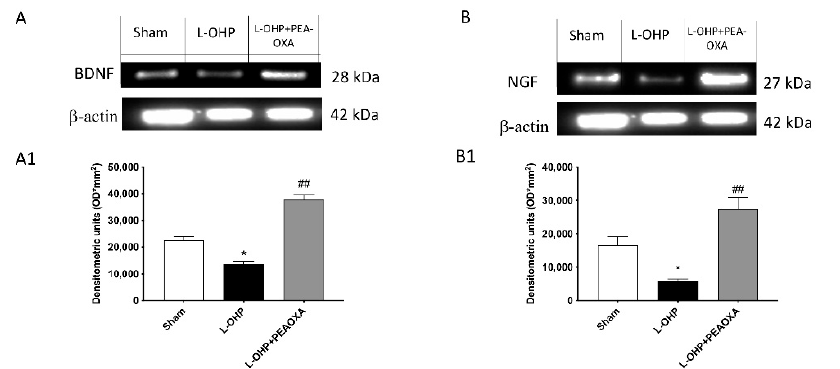
Figure 6. Effect of PEA-OXA on BDNF and NGF expression. Western blot analysis for BDNF and NGF was made in the dorsal root ganglia (DRG). A significant reduction in neurotrophic factor, BDNF, and NGF was seen following L-OHP injection compared to the sham group ( A , B respectively), while PEA-OXA considerably upregulated BDNF and NGF expression ( A , B ); see densitometric analysis ( A1 , B1 ). The DRG samples were pulled for each group. Data are means ± SEM of 10 mice for each group. A representative blot of lysates obtained from each group is shown and densitometry analysis of all animals is reported ( n = 10 mice from each group). One-way ANOVA test; * p < 0.05 vs. sham; ## p < 0.01 vs.